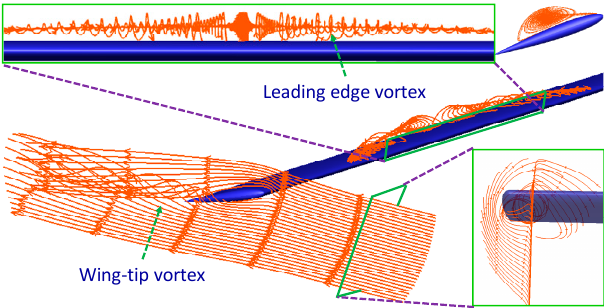
Figure 6. Spatial streamlines of wing flowfield.